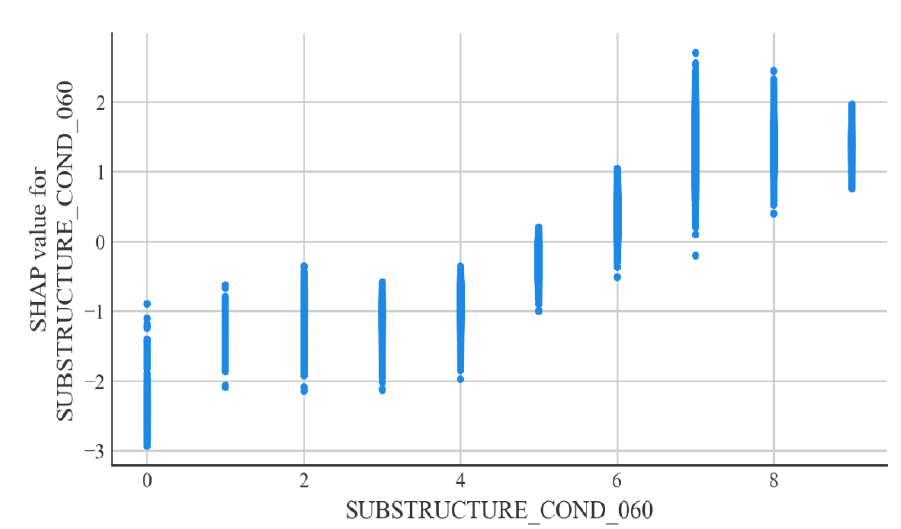
Figure 7. Bridge substructure condition characteristics dependence diagram.